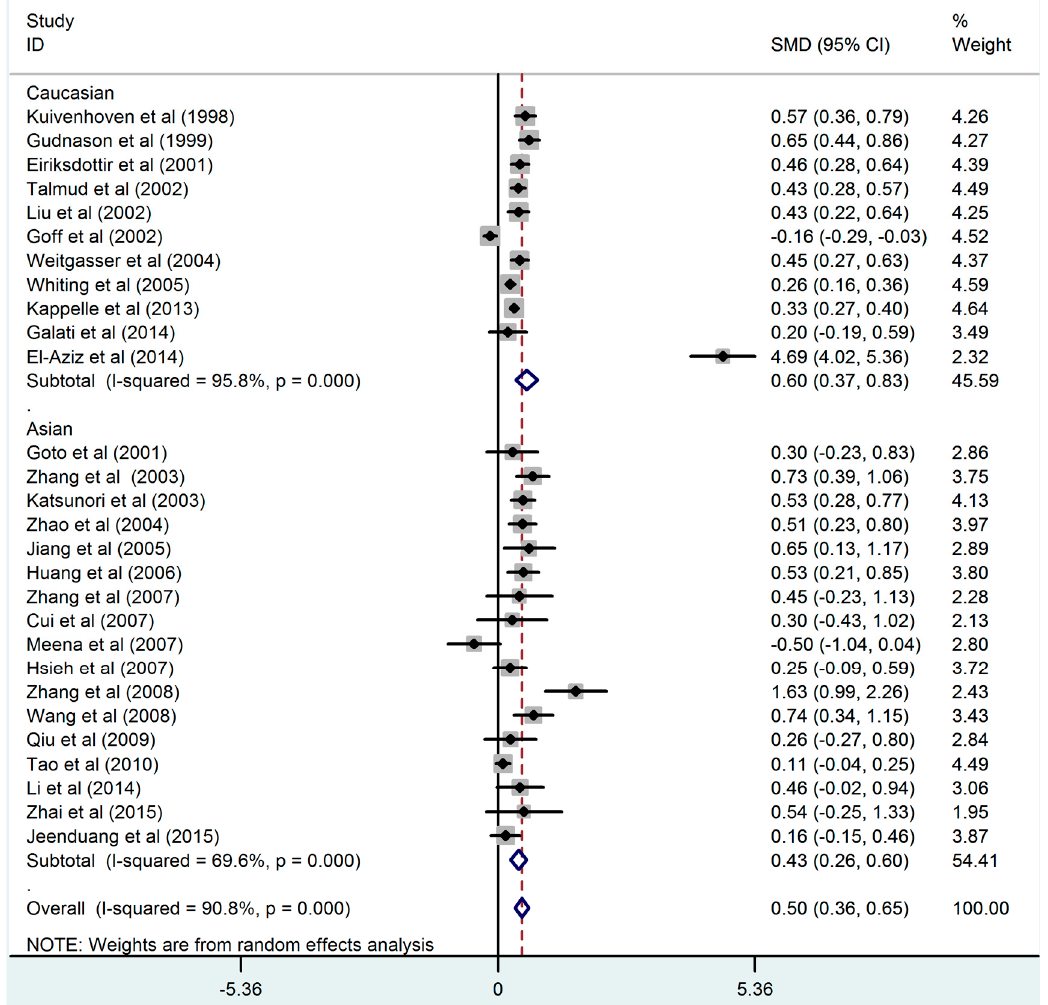
Figure 3. Association between the CETP TaqIB polymorphism and HDL-C level ( B1B1 vs. B2B2